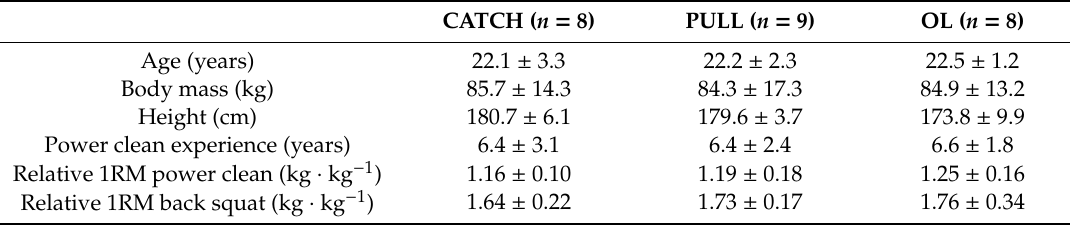
Table 1. Participant demographics for each training group.